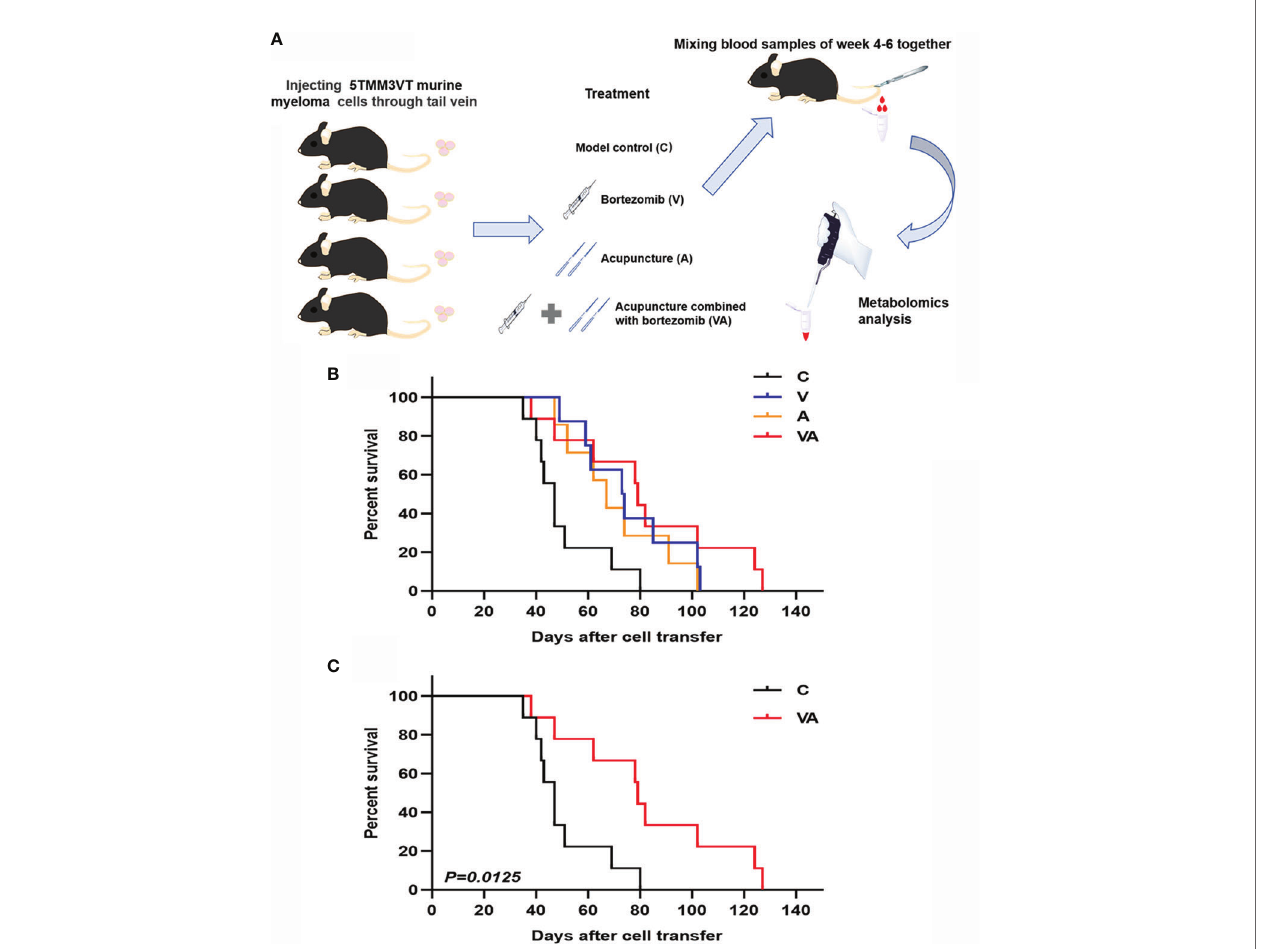
FIGURE 1 | Ef fi cacy evaluation of VA treatment in 5TMM3VT myeloma mice. (A) Animal model and blood collection. (B) Survival curve of group C, V, A, and VA. (C) Survival curve of group C vs